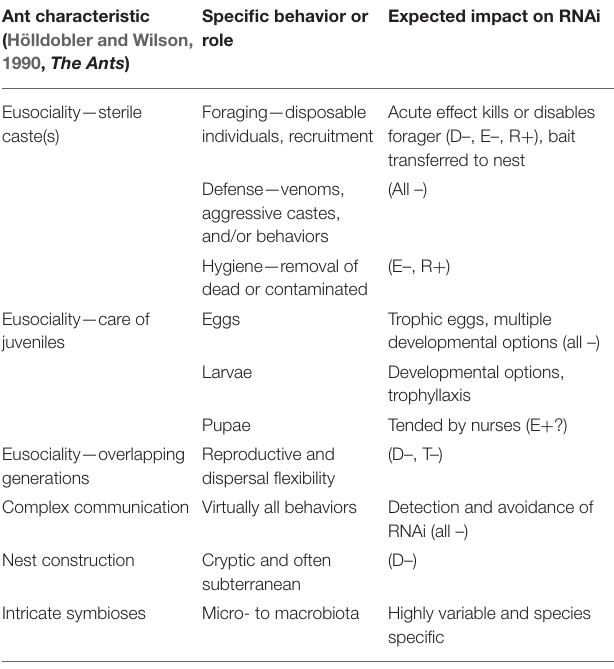
TABLE 1 | Characteristics of ants that may impact RNAi and need further